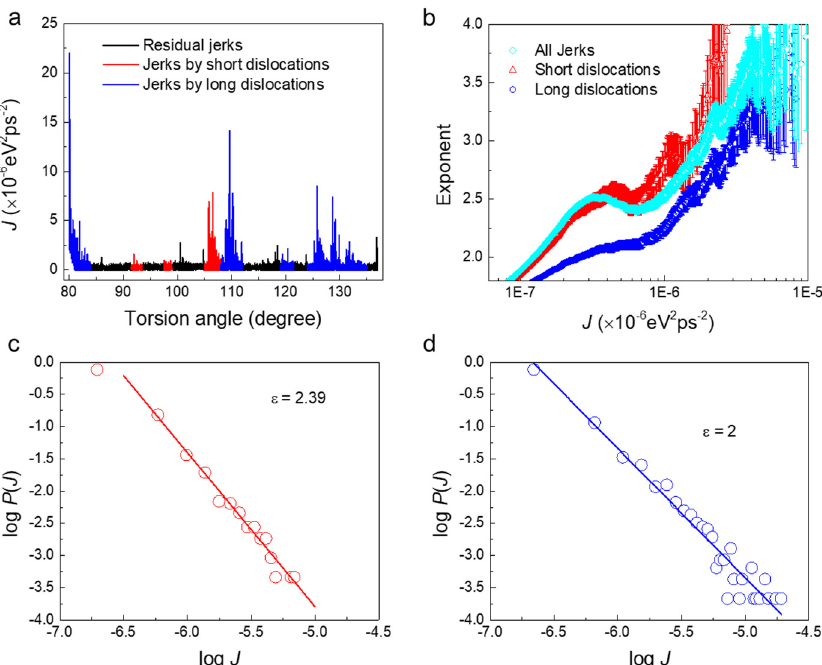
Figure 4. Statistical analysis of the jerk strength for pristine nanowires under twisting at stage A. ( a ) Jerk spectrum at 80° < θ < 137°. The jerks stem from movements of short dislocations near the loading end (red) and from long dislocations along the length direction (blue). ( b ) Exponents found by the maximum likelihood (ML) analysis of all jerks (cyan), jerks induced by short dislocations (red) and jerks induced by long dislocations (blue). ( c ) Log-log plot of the probability distribution function (PDF) of jerks induced by short dislocations (red in Figure 4a) showing a power-law distribution with an exponent of 2.39. ( d ) PDF log-log plot of jerks induced by long dislocations (blue in Figure 4a) showing a power-law distribution with an exponent 𝜀 = 2.0.